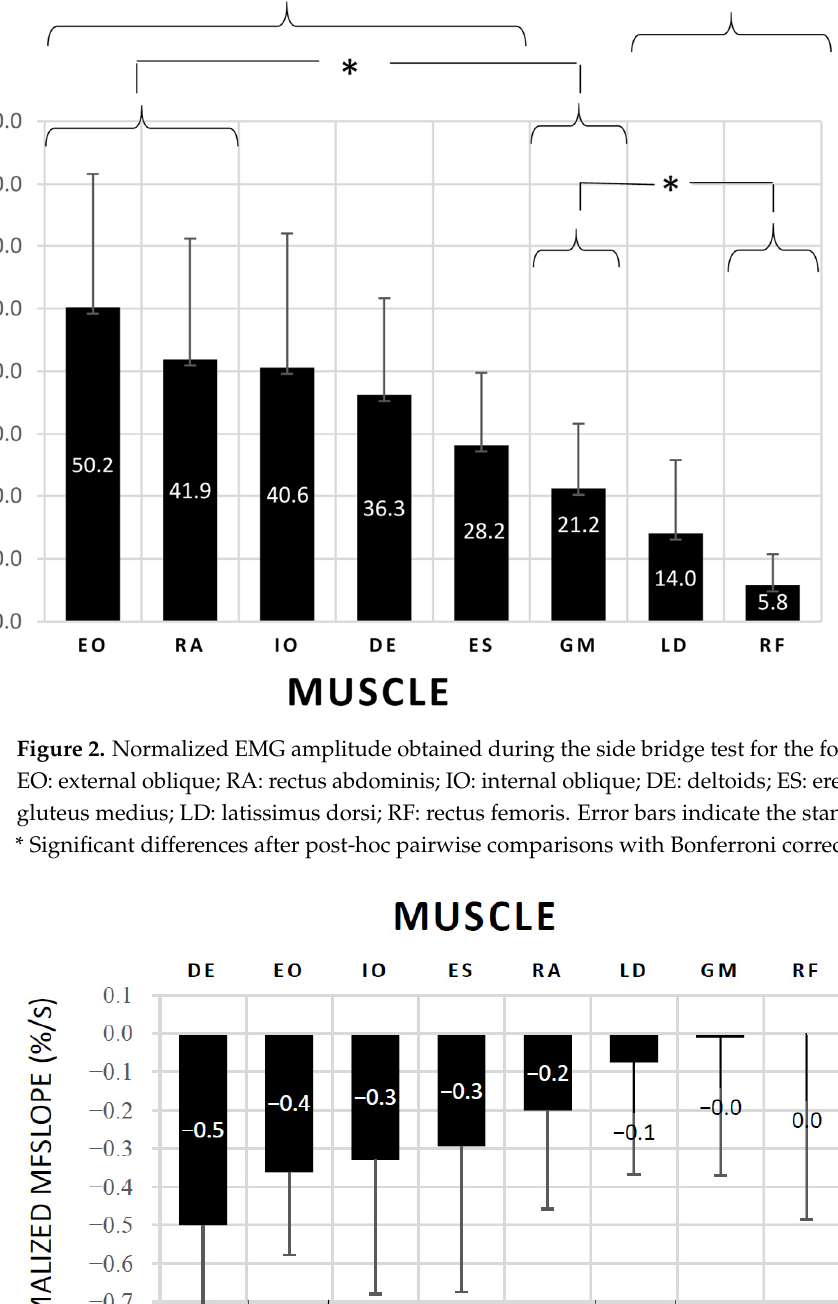
Figure 3. NMFslope obtained during the side bridge test for the following muscles: EO: external